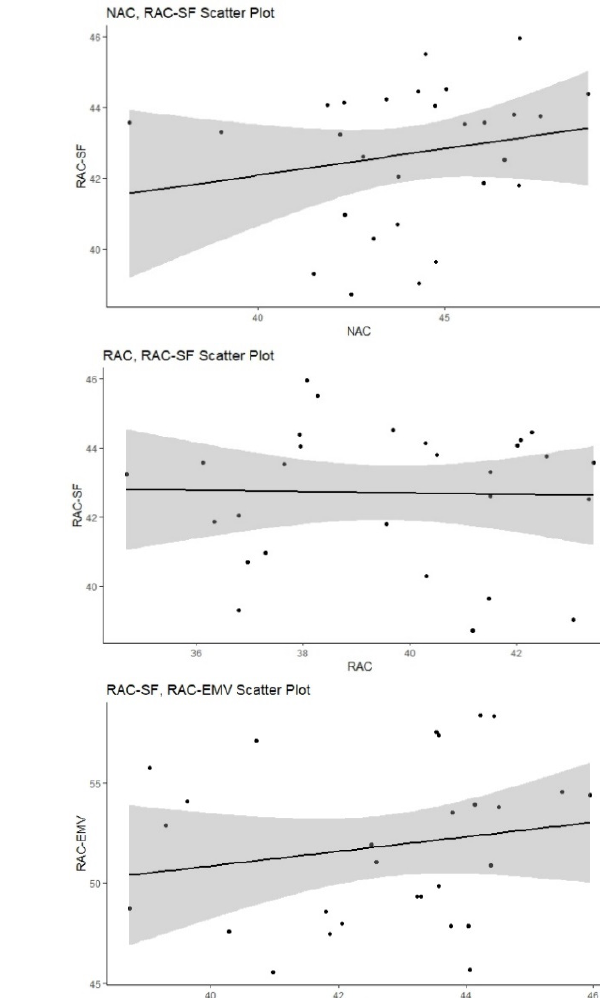
interval (CI) which indicated the same interpretation with correlation coefficient.